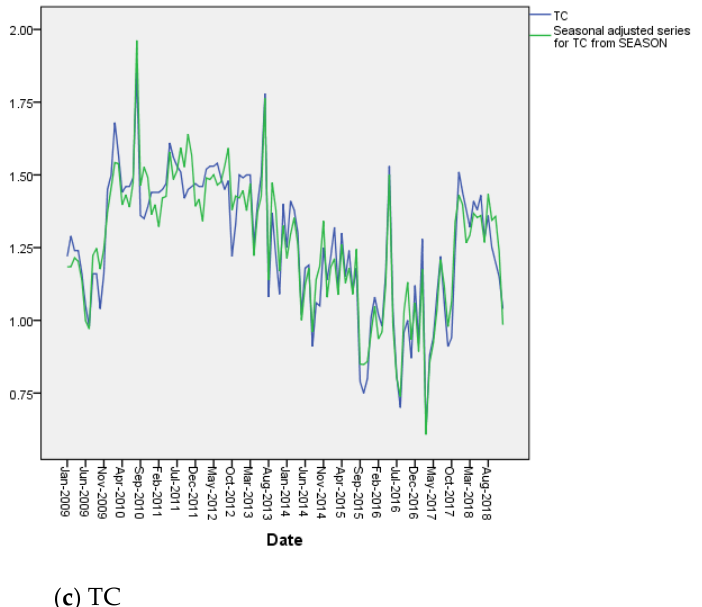
Figure 5. The original series and the series corrected for seasonal factors.